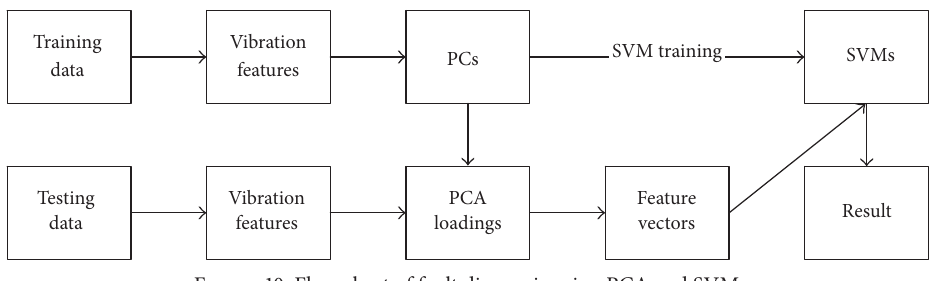
Figure 10: Flow chart of fault diagnosis using PCA and SVM.